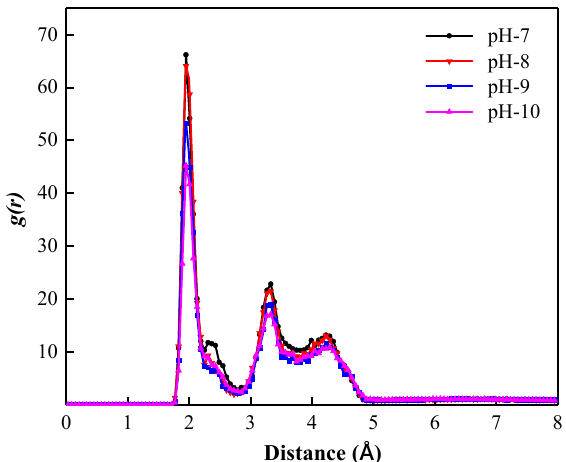
Figure 15. Radial distribution functions of SDBS head group and surrounding monovalent cations in foam systems with different pH.